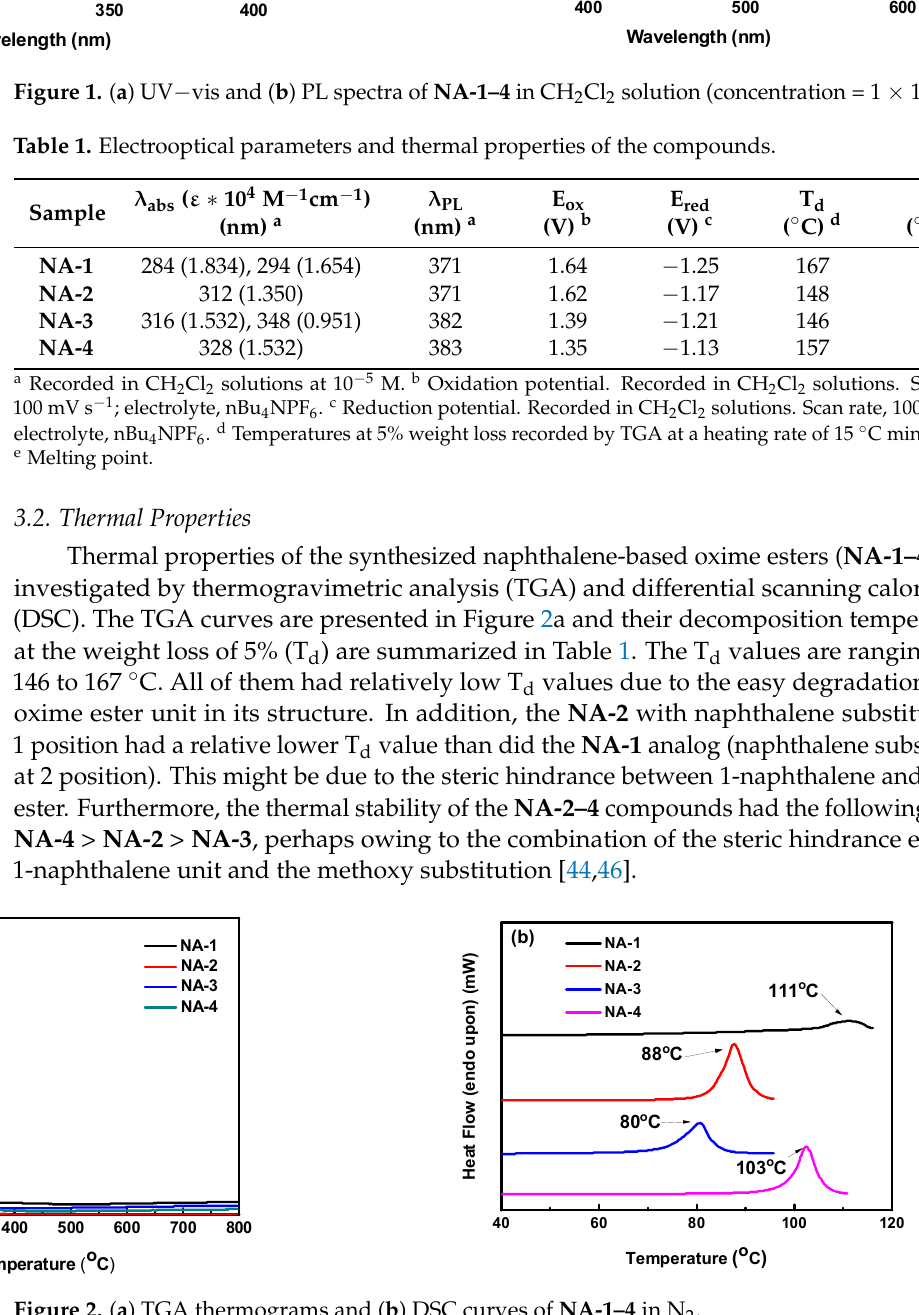
Figure 2. ( a ) TGA thermograms and ( b ) DSC curves of NA-1–4 in N 2 .